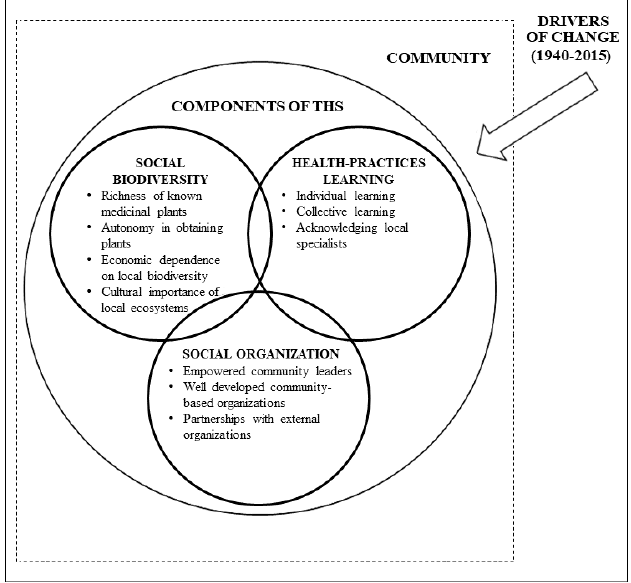
Fig. 2 . Components of social biodiversity, health-practices learning, and social organization affecting resilience and adaptive capacity of studied traditional healthcare systems